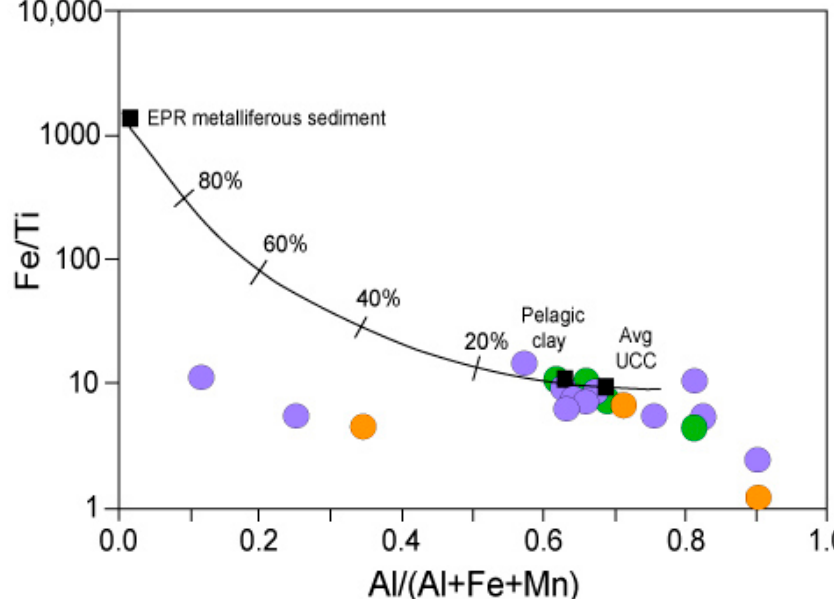
Figure 11. Plot of biotite gneiss from the New Jersey Highlands on a diagram of Fe/Ti versus Al/Al + Fe + Mn [43]. Numbers on curve represent percent of mixture of hydrothermal sediment (EPR metalliferous sediment) and clastic sediment (pelagic clay). Average upper continental crust (UCC) from [23]. Symbols as in Figure 5.